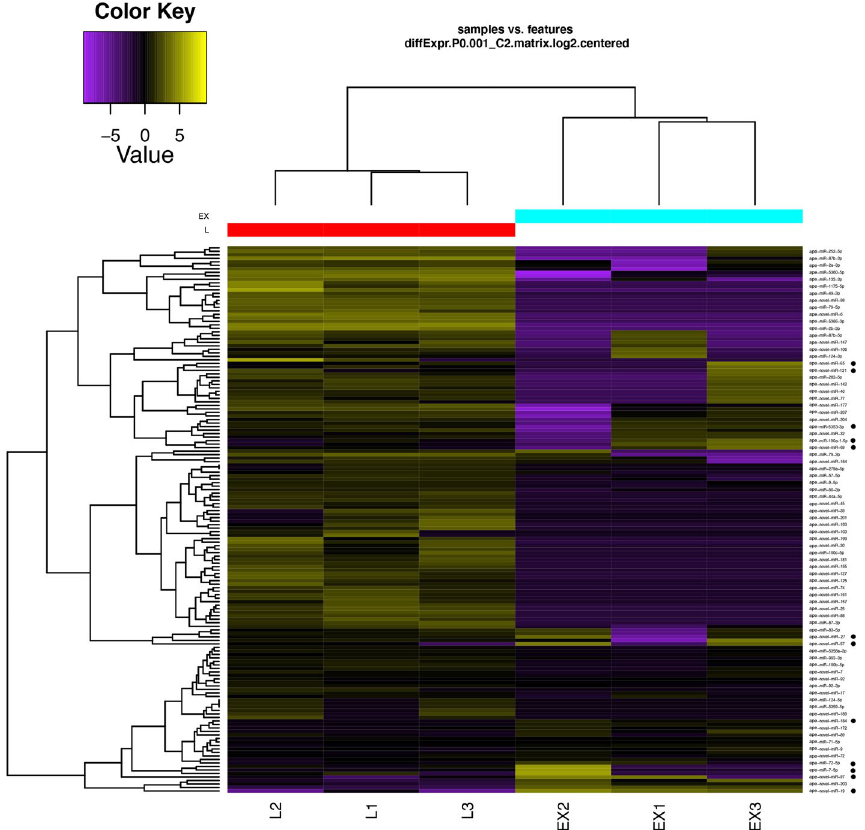
Figure 4. Heatmap and hierarchical clustering of mature miRNAs expression profiles of the third stage larvae of A. pegreffii (L) and of its released extracellular vesicles (EX). Each line corresponds to the mean-centered log2-transformed CPM, colored according to upregulation (yellow) and downregulation (violet). Upregulated miRNAs in EVs sample are indicated with a black